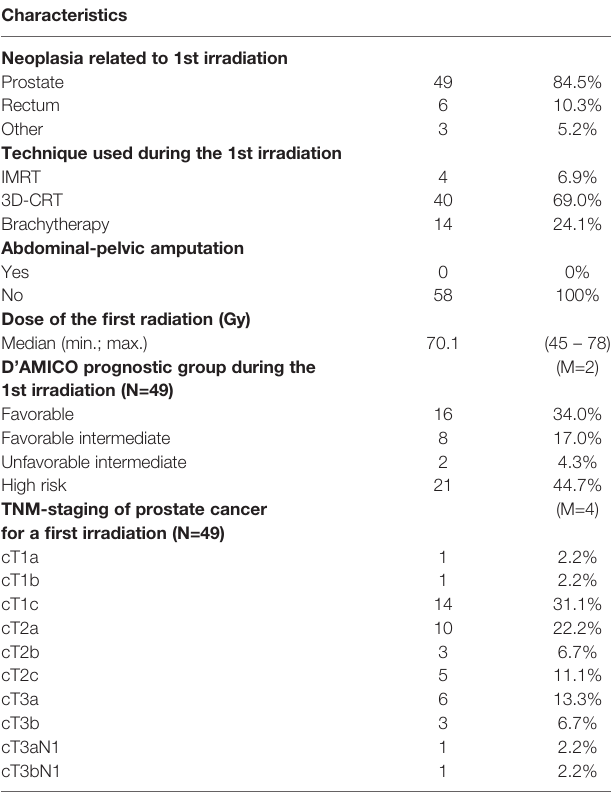
TABLE 2 | Patient, tumor and treatments characteristics at the time of fi rst irradiation in patients who had SBRT as “ re-irradiation ”